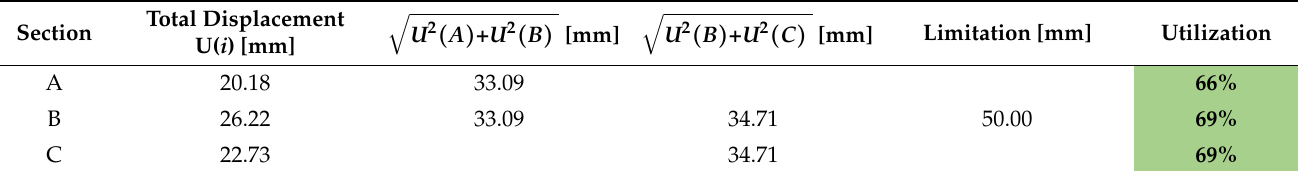
Table 7. Validation of seismic joints (EN